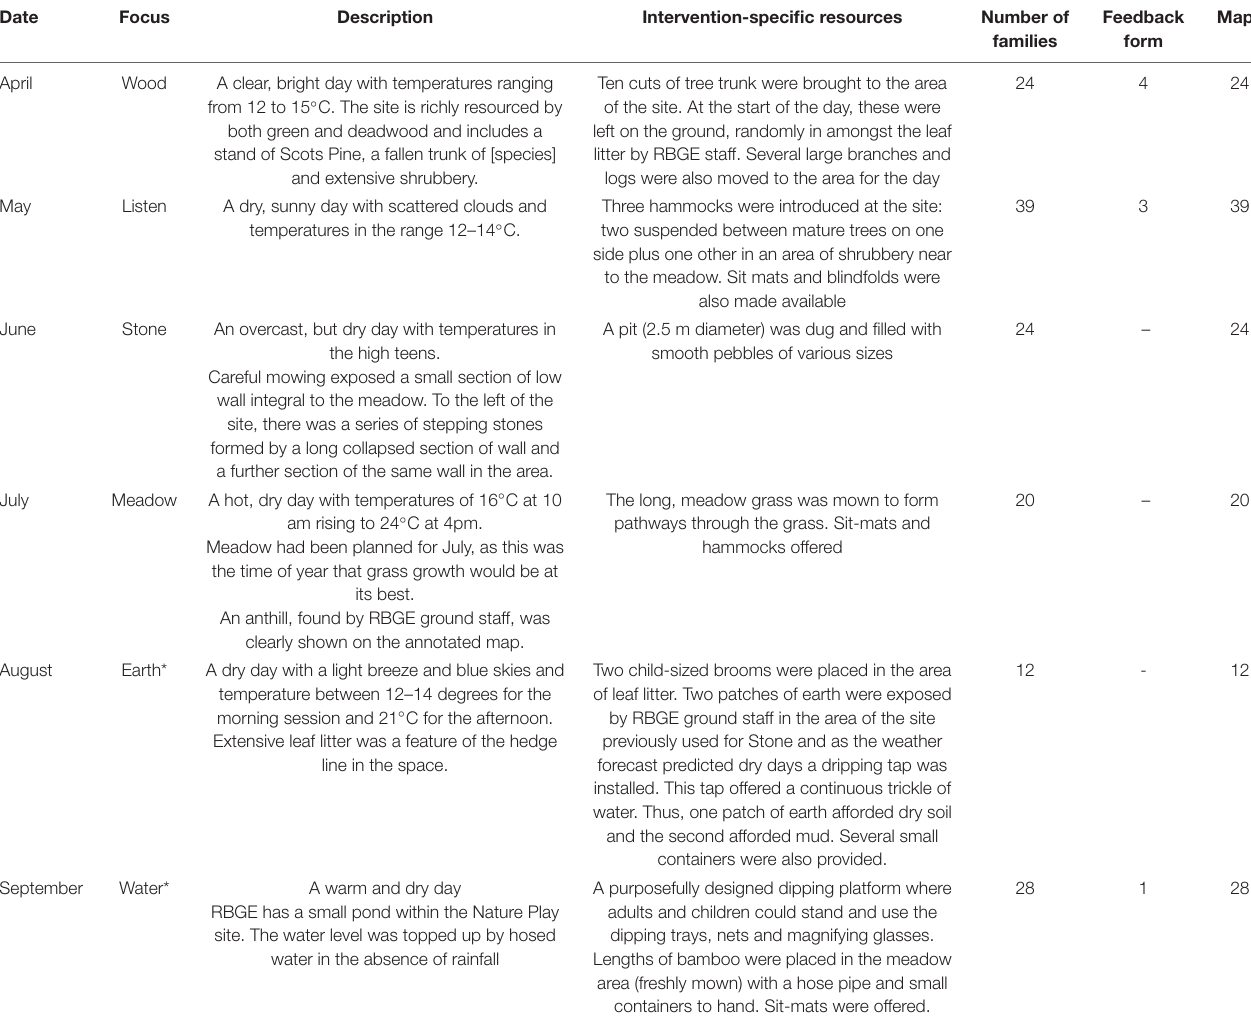
TABLE 1 | Description of interventions and participant